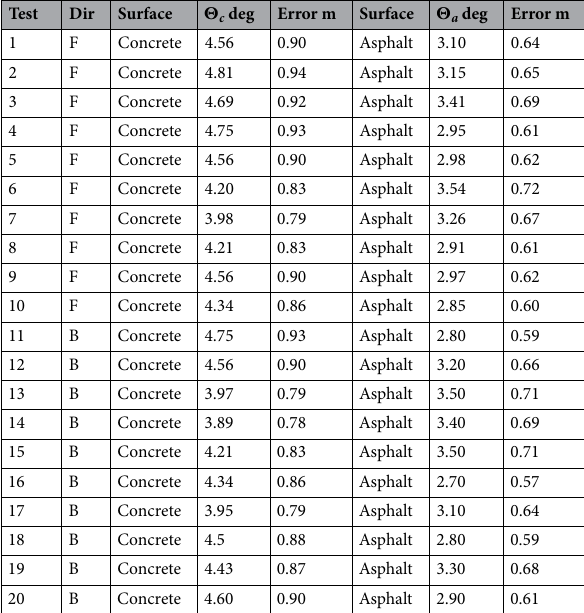
Table 4. Errors and yaw angle deviation for each test.